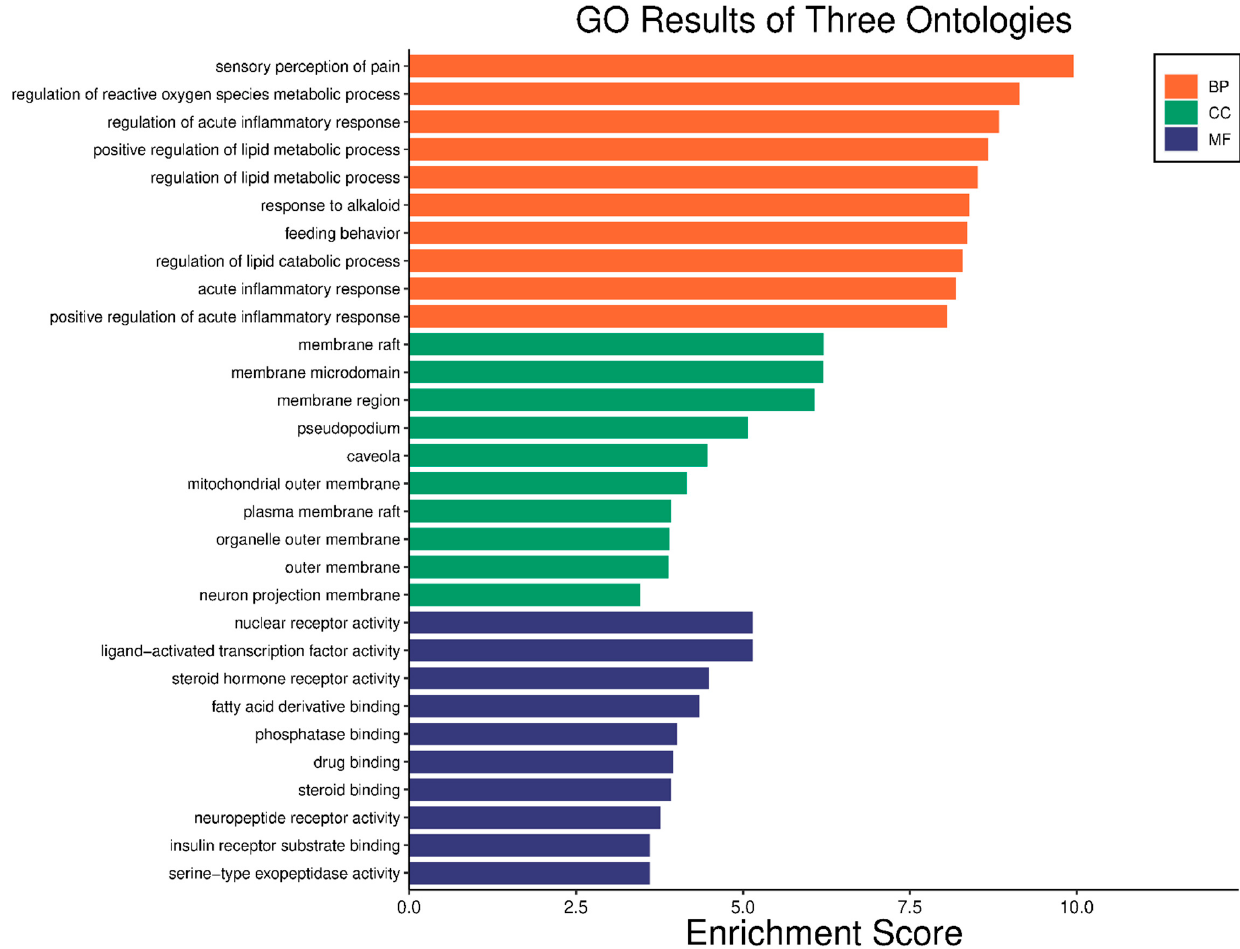
Figure 4. GO analysis in terms of biological process BP (orange color), cellular compartment CC (green color), and molecular function MF (blue color).